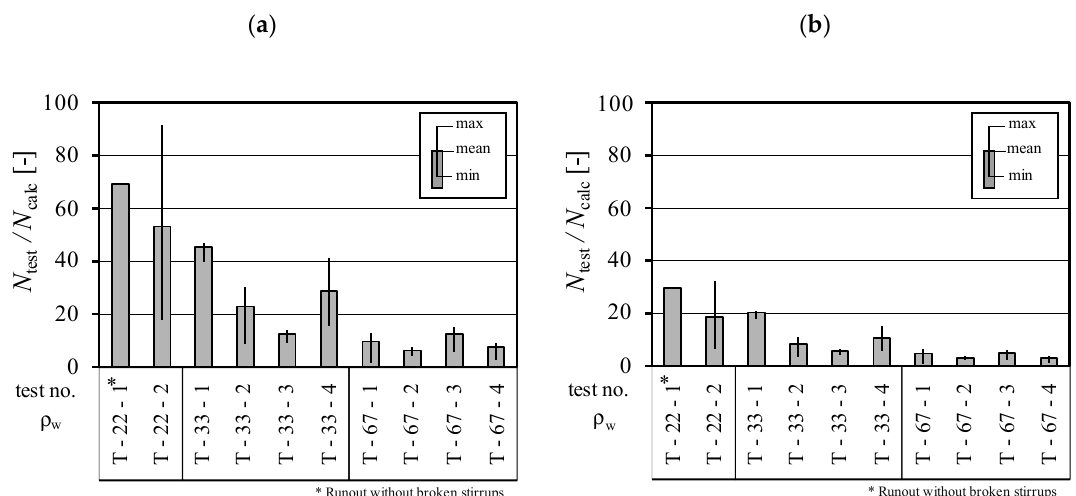
Figure 9. Ratio of the experimental and calculated number of cycles until fatigue failure based on strut inclination, according to Equation (3) and the S–N curve according to ( a ) DIN EN 1992 1-1 / NA [7] and ( b ) Maurer et al. [45].